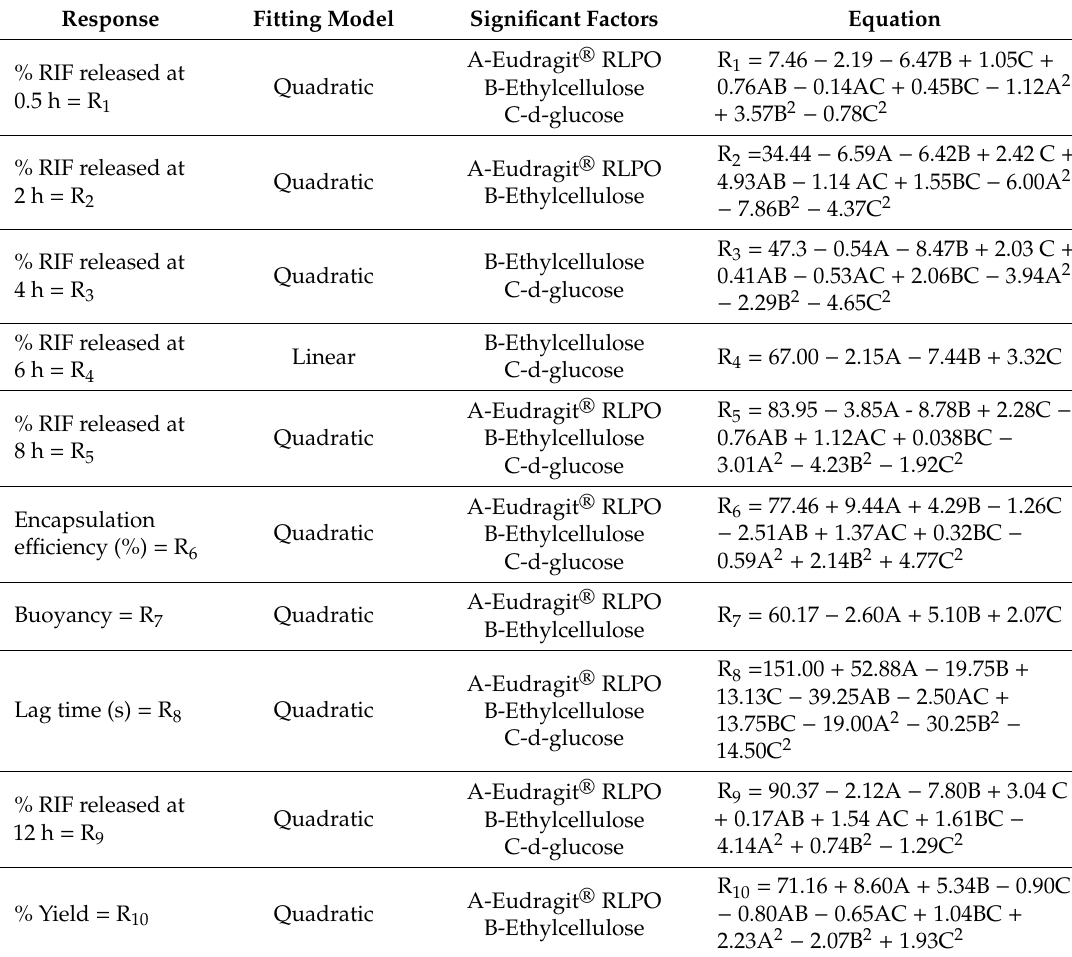
Table 10. Summary of best fit models, significant factors, and equations describing the relationship between input variables and response for RIF